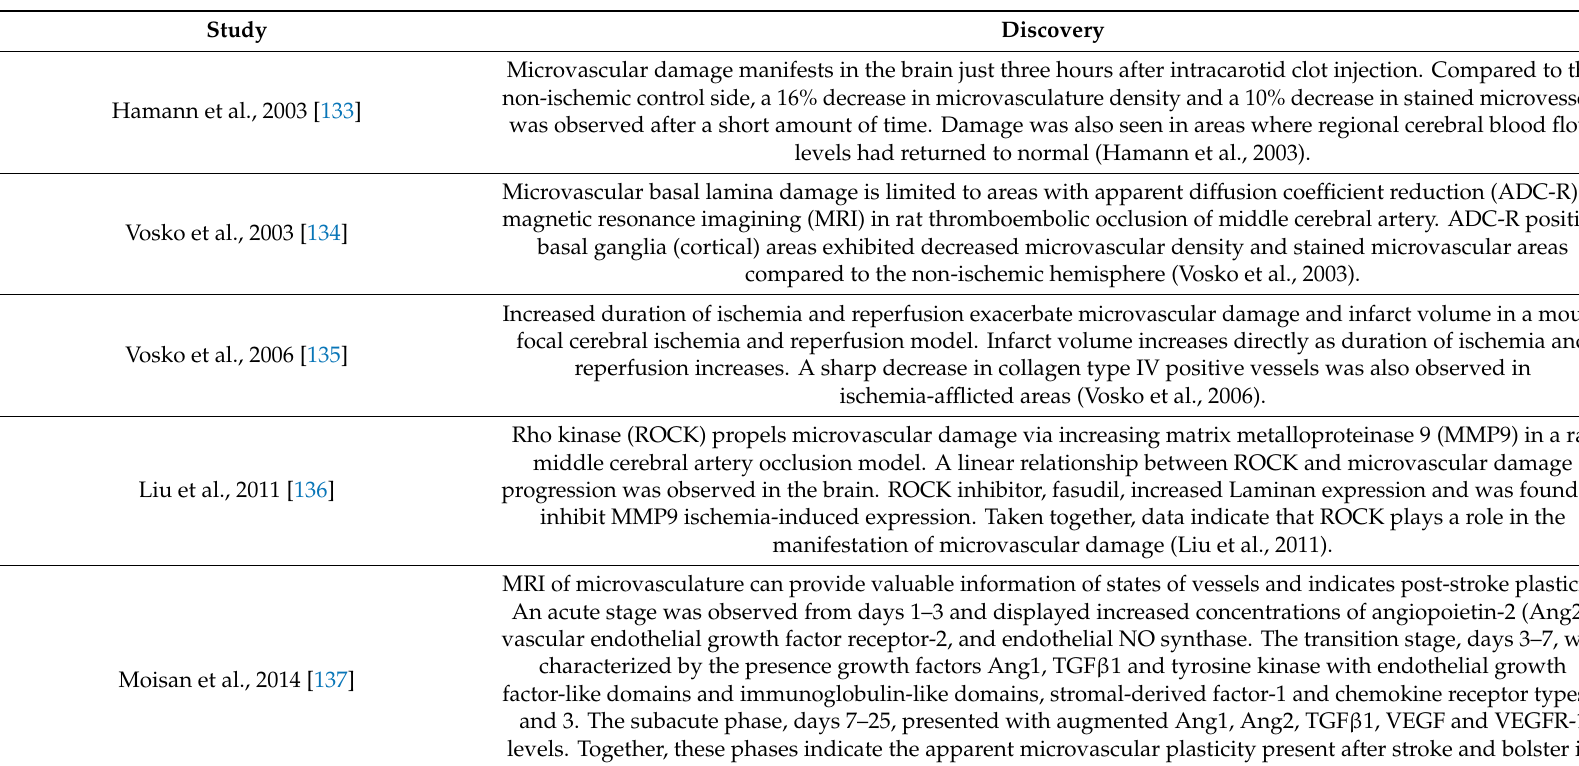
Table 1. Stroke and Microvascular Disease. This table highlights milestone discoveries highlighting the pathological links between stroke and microvascular